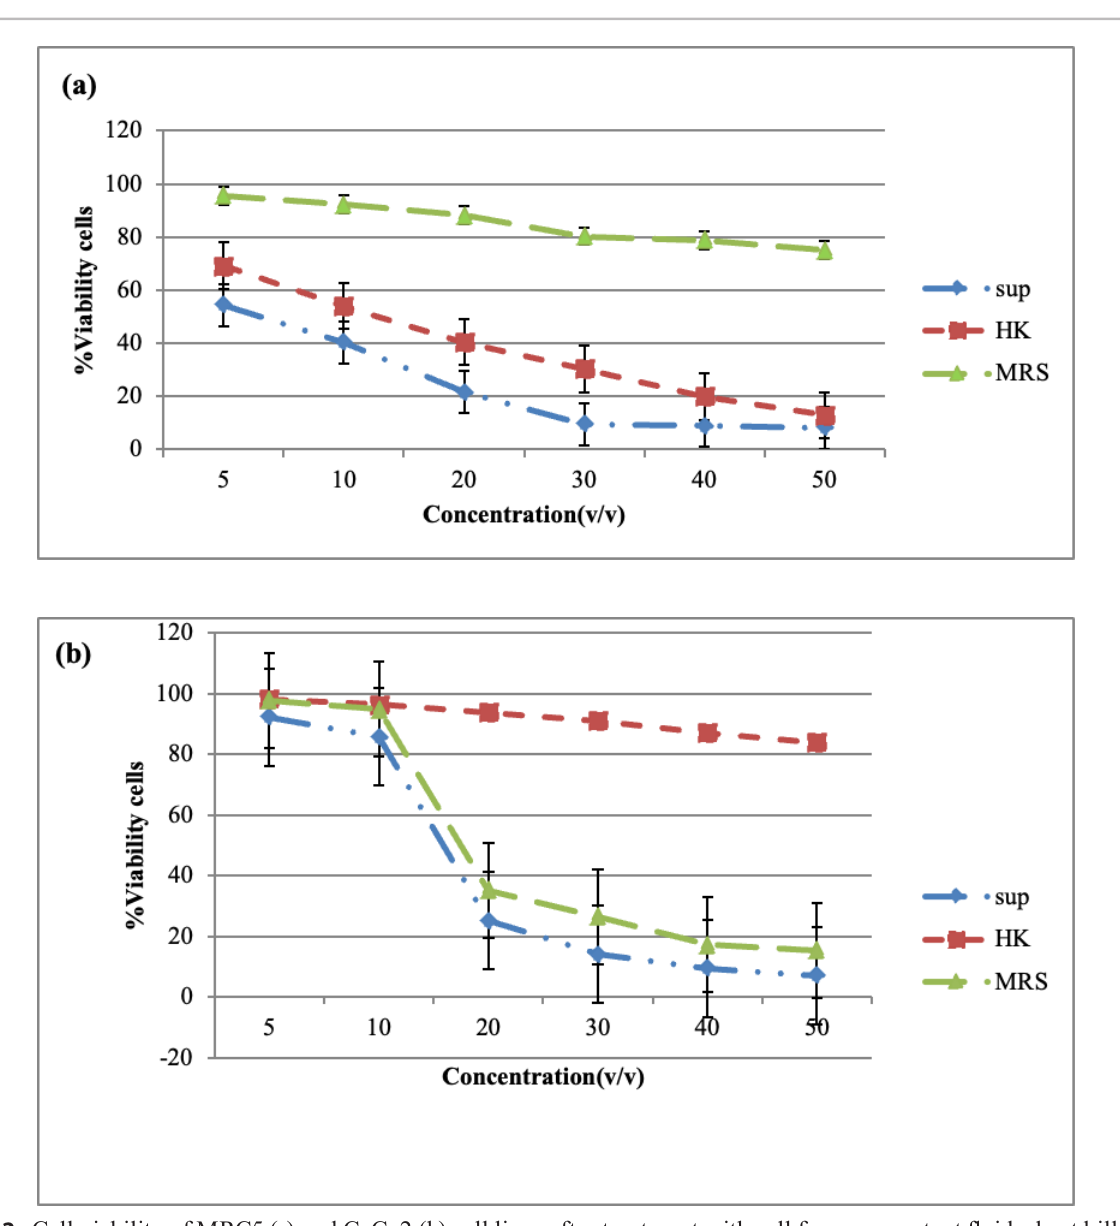
FIGURE 2 - Cell viability of MRC5 (a) and CaCo2 (b) cell lines after treatment with cell free supernatant fluids, heat killed cells of L.casei RTCC 1296-2 and MRS medium, analyzed by MTT assay. All results are mean (SD±) of three individual